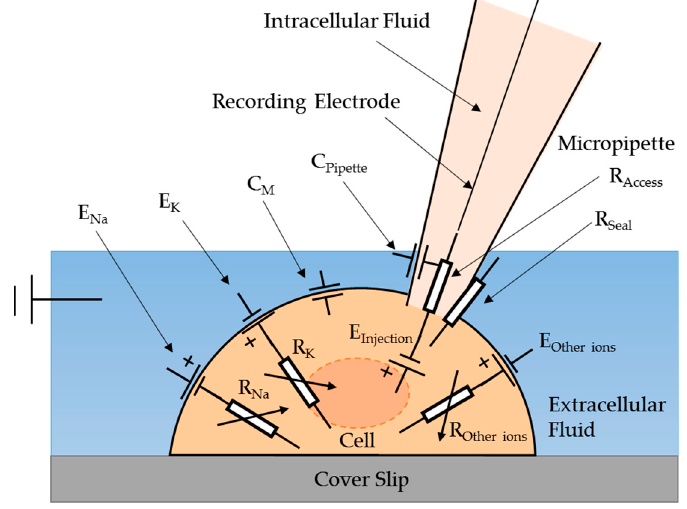
Figure 1. The electric equivalent model of the cell ctoplasmic injection.